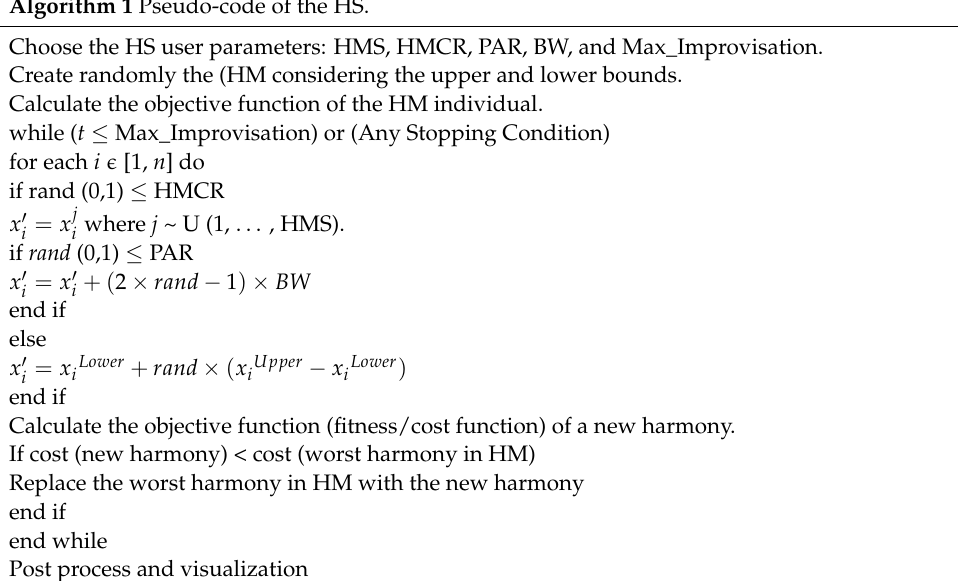
Algorithm 1 Pseudo-code of the